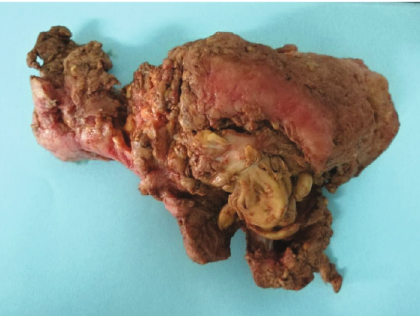
Figure 1: Gross examination showed an ill-de fi ned submucosal fi broid mass excised from the uterus measuring 12 × 11 × 7 cm with few gray- pink in color polypoid masses measuring 2-3 cm that are soft to rubbery in consistency.